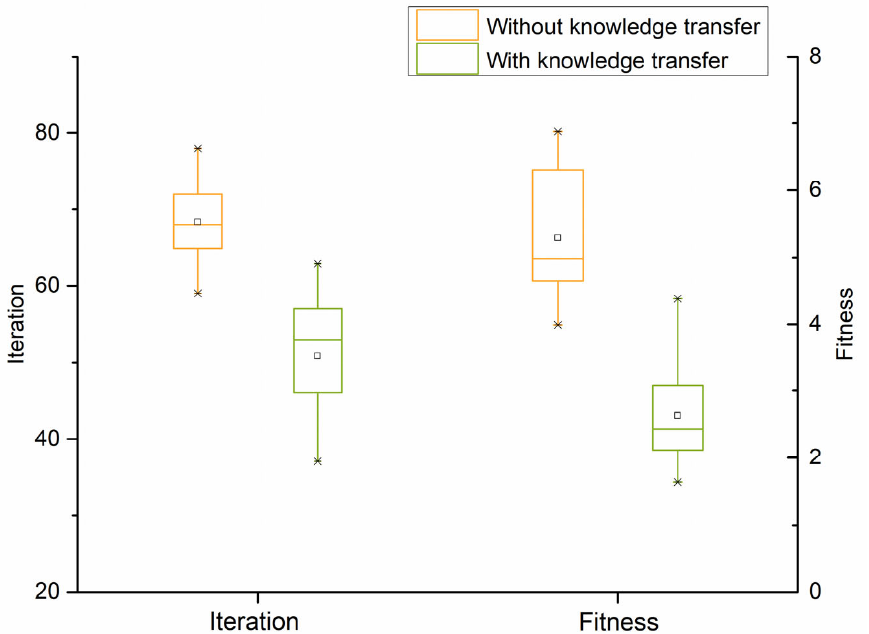
Figure 13. Comparison of statistics with and without introducing the knowledge transfer surro- gate. Square represents mean.